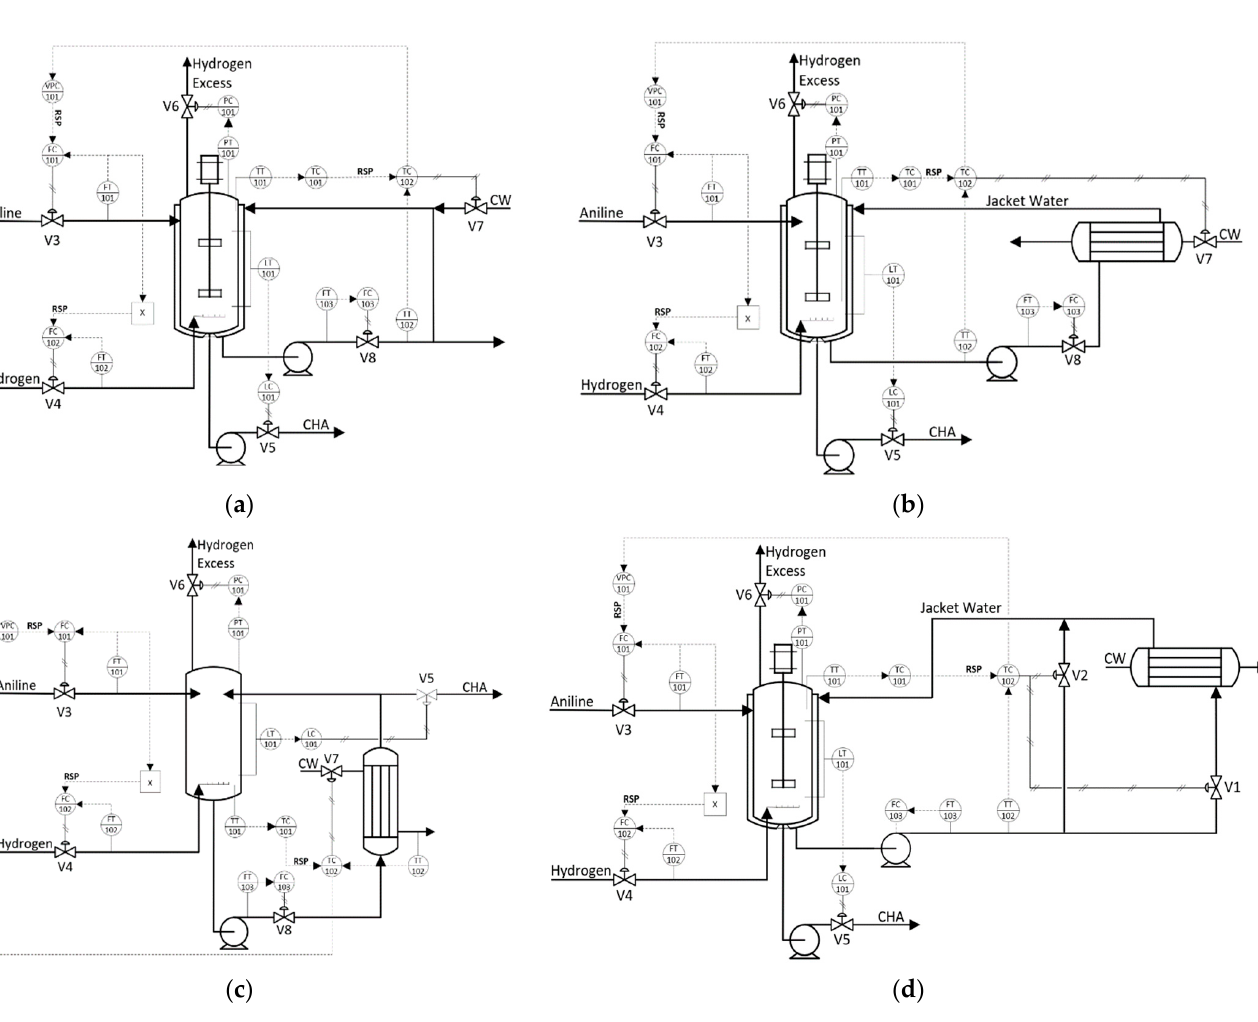
Figure 7. Control scheme for ( a ) design A, ( b ) design B, ( c ) design C, ( d ) design D.